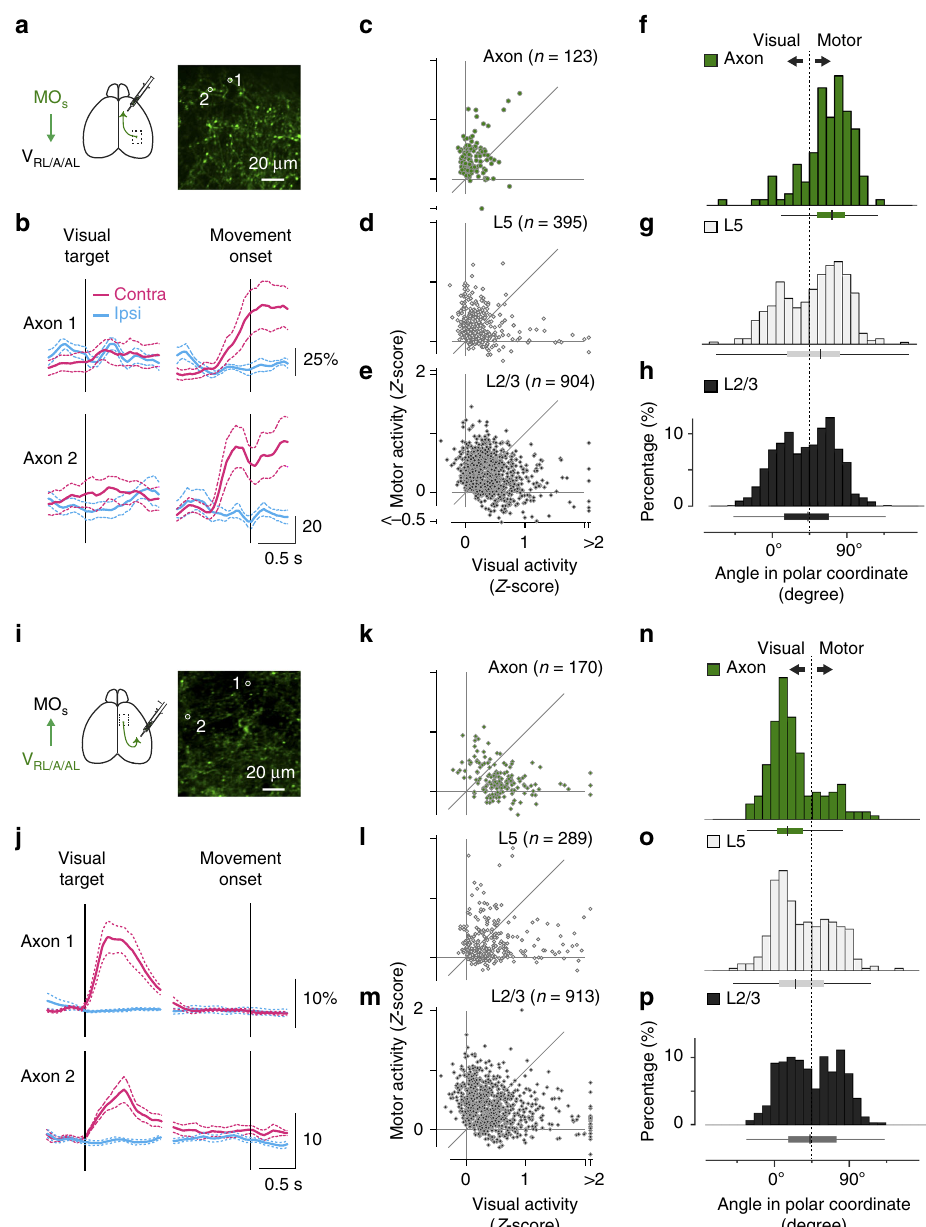
Fig. 6 Biased neural coding in MO s and V RL/A/AL axons. a – c Coding in MO s axon terminals projecting to the V RL/A/AL . a GCaMP6f was expressed in MO s neurons, and their axons were imaged in the V RL/A/AL . b Calcium traces from two representative axons (mean ± s.e.m., cyan for the ipsiversive movement condition; magenta for the contraversive). The corresponding ROIs are shown in a . c – e Comparison between visual and motor activity for MO s axons ( c , n = 123), L5 somas ( d , n = 395), and L2/3 somas ( e , n = 904). f – h Histograms of the angle in polar coordinates for MO s axons, L5 neurons, and L2/3 neurons. The distribution of the axons is more biased towards 90 degrees, indicating higher motor selectivity. Median, 25% quantile, and 75% quantile are represented as box plots, whisker length is 1.5 of the interquartile range. i – p Similar to a – h , but for V RL/A/AL axon terminals projecting to the MO s . V RL/A/AL axons, n = 170; V RL/A/AL L5 somas, n = 289; L2/3 somas, n = 913. Note skewed distribution of the axons towards 0 degrees, indicating higher visual selectivity. The histograms for L2/3 somas ( h , p ) are the same with those in Fig. 5h, similarly evaluated and was found to be slightly less in the V RL/A/ based on the Cartesian representation of visual and motor activity = 669, (Fig. 5g, i, k). In the polar representation, the angle of 90° indi- AL than the MO s (Supplementary Fig. 15b, d, MO s , n V RL/A/AL , n = 705; p < 0.001, Mann – Whitney test) but much cates strong preference for motor information, and 0° for visual stronger than the V1 (Supplementary Fig. 15d, f, V RL/A/AL , information. The distribution of the polar angles indicate that the − 9 n = 705; V1, n = 54; p < 10 , Mann – Whitney test, the post- preference for motor over visual activity across neurons in the movement activity represents an intricate mixture of visual V RL/A/AL was signi fi cantly different from the V1 but not the MO s activity, remaining motor signals, and post-movement motor- (Fig. 5h, j, l, MO s , n = 904, V RL/A/AL , n = 913, V1, n = 306; related activity 36 ). These results indicate that the MO s and the p < 10 − 43 and p = 0.06, respectively, Mann – Whitney test). Pre- ference for motor activity over post-movement activity was V RL/A/AL encode qualitatively similar patterns of visual and motor